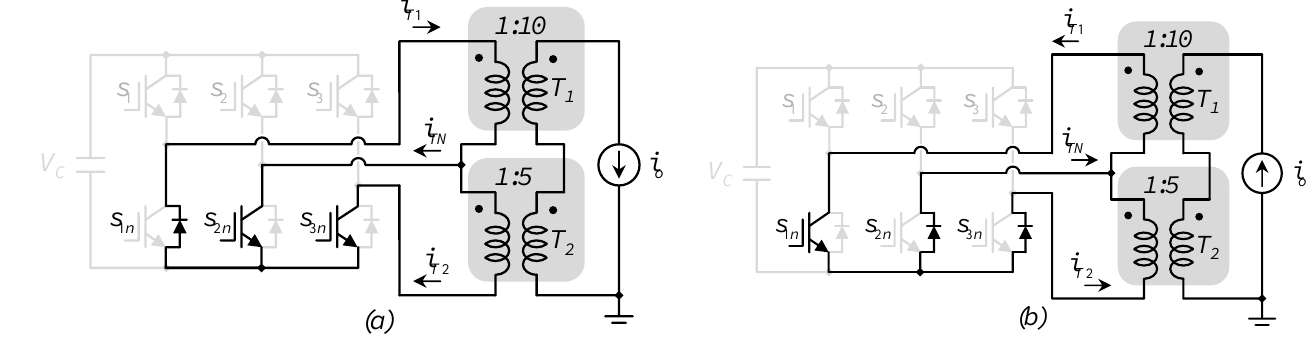
Figure 5. Current flow for different directions of the load current when s 1 = 0, s 2 = 0, and s 3 = 0. (a)